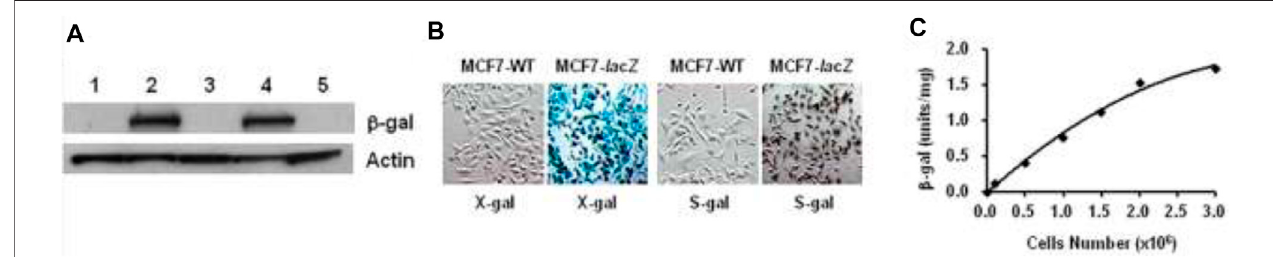
FIGURE 7 | MCF7- lacZ transfection. (A) Western blot: protein extracts from two transfected MCF7- lacZ cell lines (lanes 2,4), together with MCF7-WT cells (lanes 1,3,5) showing intense bands for β -gal activity in MCF7- lacZ cells and none in MCF7-WT cells; (B) MCF7-WT/MCF7- lacZ cells staining by X-gal and S-gal: deep blue (X-gal) and black (S-gal) staining con fi rming the intense lacZ expression in MCF7- lacZ cells with essentially no β -gal activity in MCF7-WT cells. Regional magni fi cation × 100; (C) β -Gal assayfor activity quanti fi cation in MCF7- lacZ cells: 1.0 unit corresponding tothe hydrolysisof1.0 μ mol/min O -nitrophenyl β - D -galactopyranoside, β -gal activity was increasingly associated with the number of MCF7- lacZ cells.